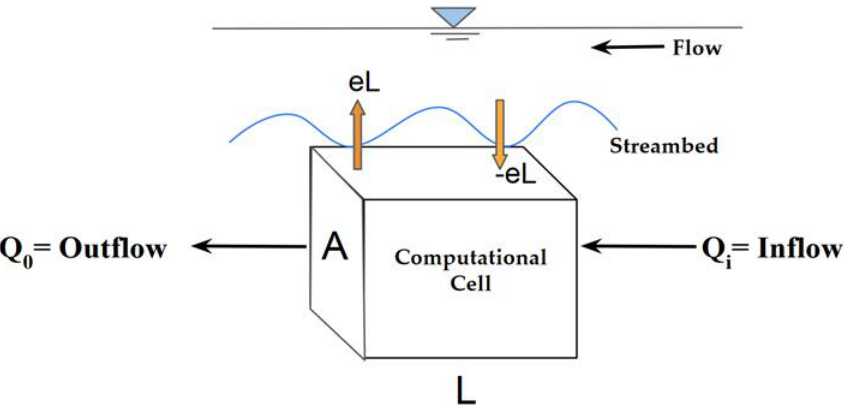
Figure 2. An elementary model to delineate the principal process of hyporheic exchange.